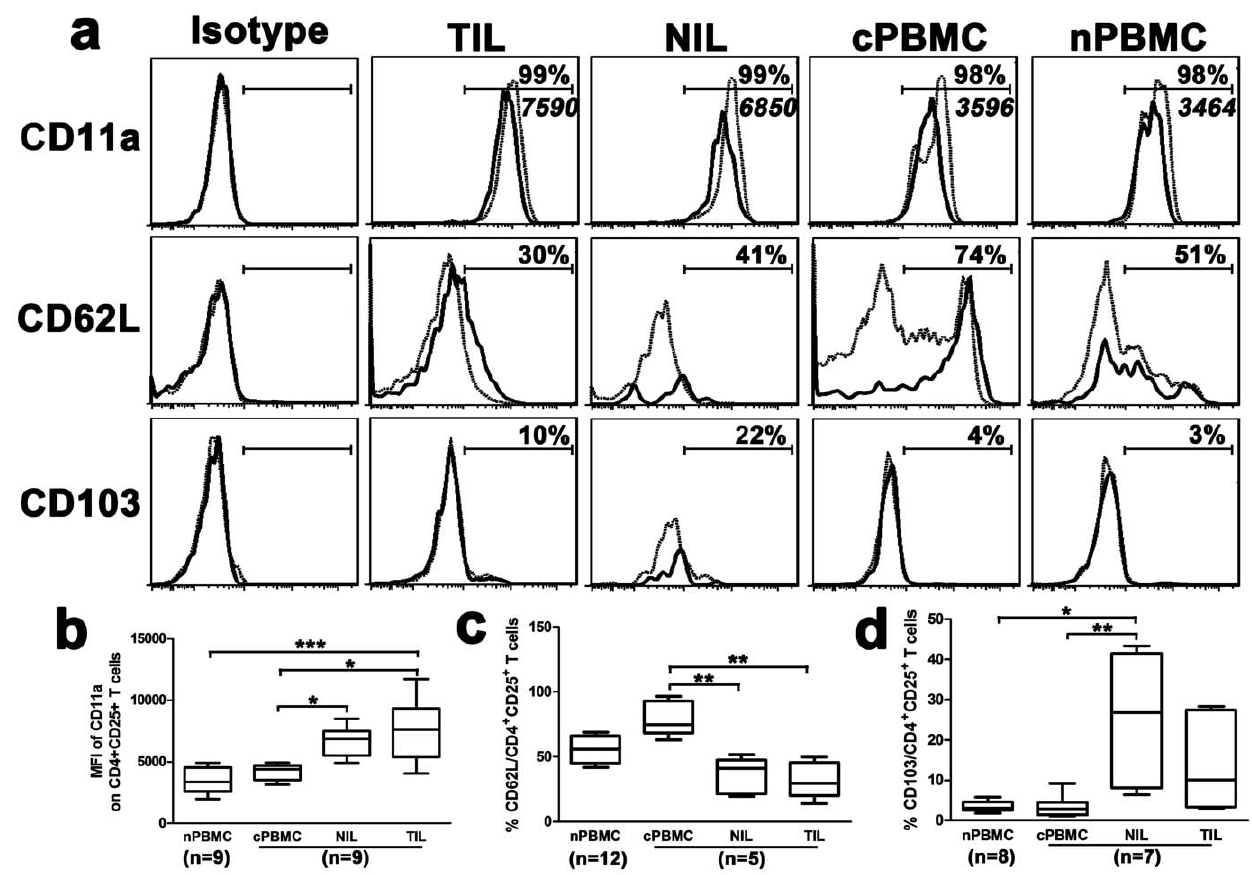
Figure 5. Differential expression of CD11a, CD62L and CD103 on CD4 + CD25 + Tregs. (a) Representative CD11a, CD62L, and CD103 expression profiles on CD4 + CD25 + (solid line) and CD4 + CD25 2 (dotted line) T cells from the four studied groups. Specific isotypes were used as negative control. The percentages represent the frequencies of various markers on CD4 + CD25 + T cells. The italic numerical values represent MFI of CD11a on CD4 + CD25 + T cells. (b–d) Statistical analyses of CD11a intensity (b), as well as CD62L (c) and CD103 (d) frequencies on CD4 + CD25 + Tregs. The data are expressed in box plots, in which the horizontal lines illustrate the 25th, 50th and 75th percentiles. * P , 0.05, ** P , 0.01, *** P , 0.001.